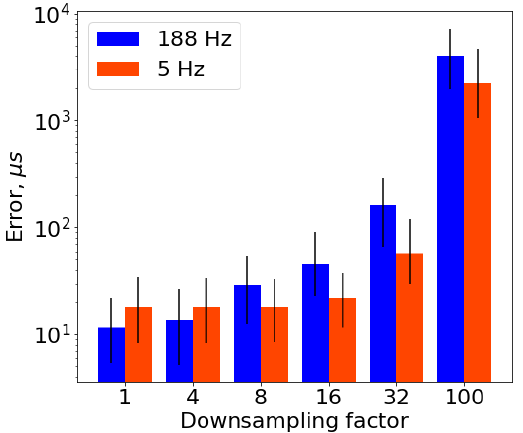
Figure 7. Error dependence on cut-off frequency for two values of cut-off frequencies and several values of downsampling factor. Height of bars are Median Absolute Error (MedAE); length of lines are Interquartile Range